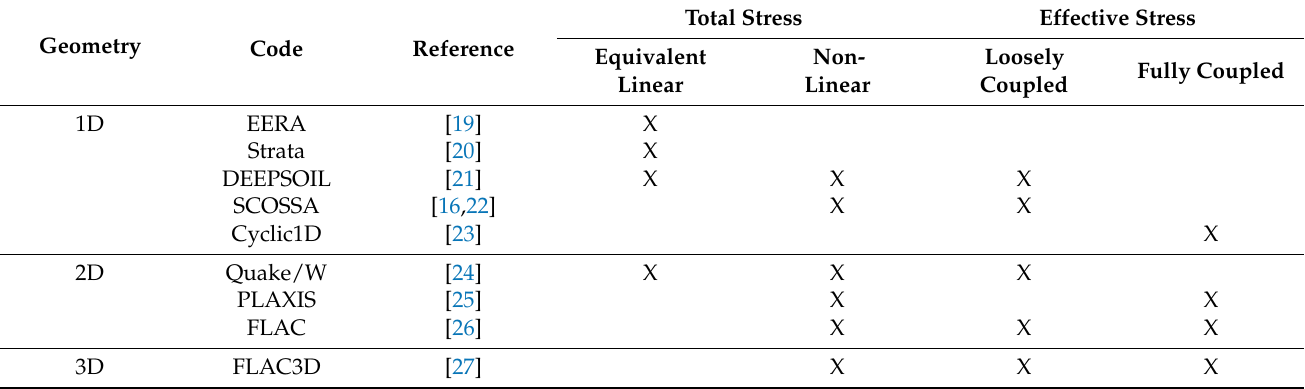
Table 1. Adopted computer codes and related capabilities for seismic response